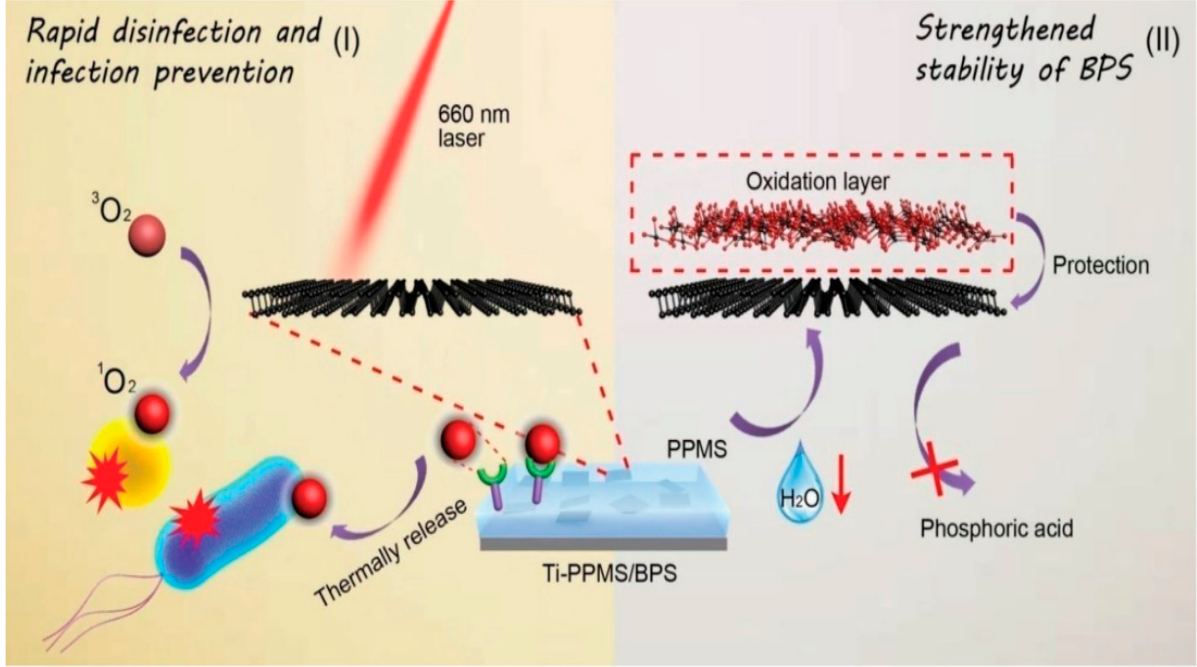
Figure 5. Schematic illustration of the Ti–PPMS–BS-based photo-antibacterial activity. The image was taken with permission [82] .